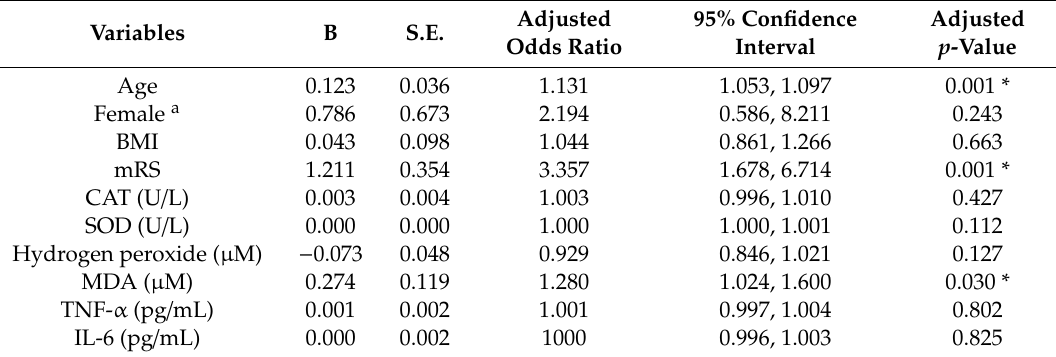
Table 4. Multivariate logistic regression analysis determining variables associated with low hand grip strength risk in stroke